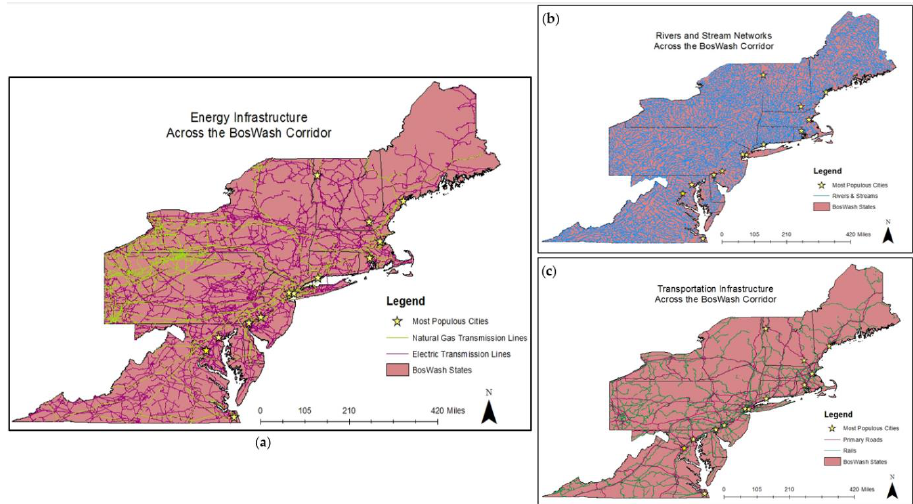
Figure 1. Maps of the BosWash region highlighting networks of various infrastructure systems. ( a ) Energy infrastructure networks of the BosWash corridor including major natural gas transmission lines [19] and electric transmission lines [20]. ( b ) Rivers and streams across the BosWash corridor [21]. ( c ) Map of the major roadways [22] and railroad networks [23] connecting states and urban areas across the BosWash corridor. These systems of infrastructure demonstrate the interconnectedness of the region and the complexity of infrastructure networks that connect beyond jurisdictions.